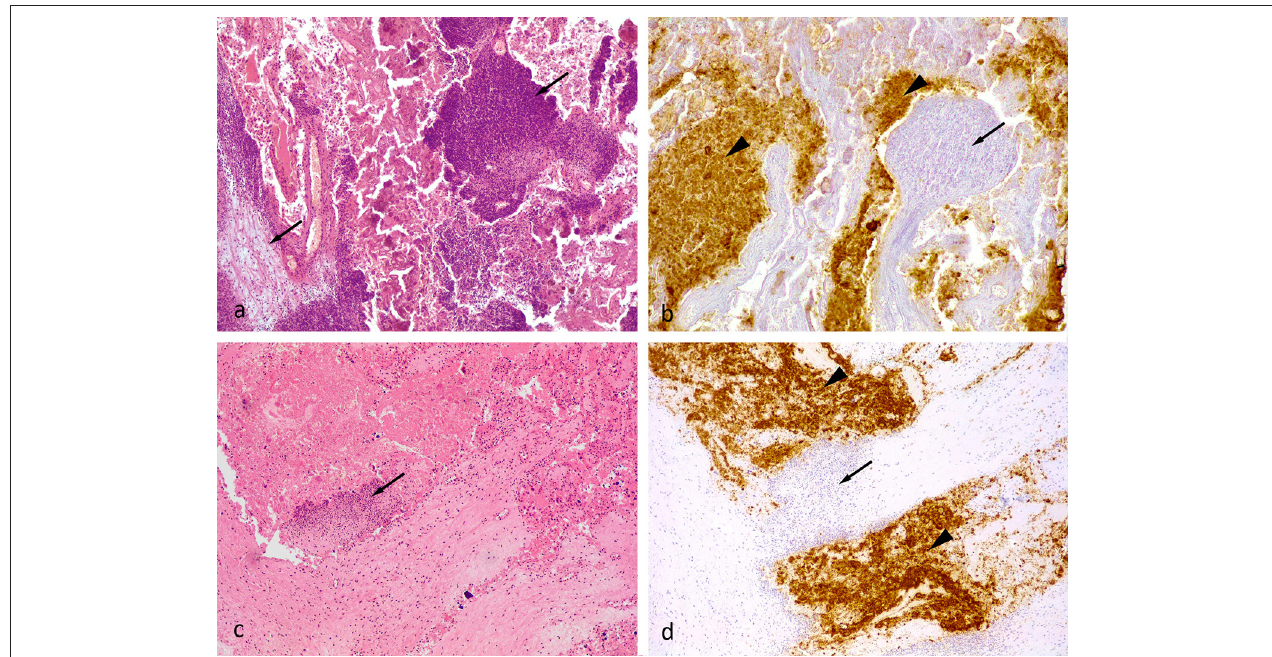
FIGURE 2 | (a) Ovine placenta, midgestation, from an unvaccinated aborted fetus (positive control). Severe multifocal necro-suppurative placentitis. The inflammatory cell infiltrate, primarily neutrophils and cellular debris, was in the villous projections of the maternal caruncle (arrows). HE. 10x. (b) The Chlamydial antigen (brown pigment) was present within necrotic villous projections of the fetal cotyledons (arrowhead). There was little to no labeling within the inflammatory cell infiltrate present within the maternal caruncles (arrow). Semi-serial section of (a) . Chlamydial antigen IHC. 10x. (c) Placental sample from a stillborn unvaccinated animal (positive control). Mild suppurative placentitis as denoted by a single focus of inflammatory cells, primarily neutrophils, within a villous projection of the maternal caruncle (arrow). HE. 10x. (d) Semi-serial section of (c) . Similar to figure (b) , the chlamydial antigen (brown pigment) was present mostly in the cellular debris within the fetal cotyledon (arrowhead). There was little to no labeling within the inflammatory cell infiltrate within the tissue of the maternal caruncles (arrow). Chlamydial antigen IHC. 10x.